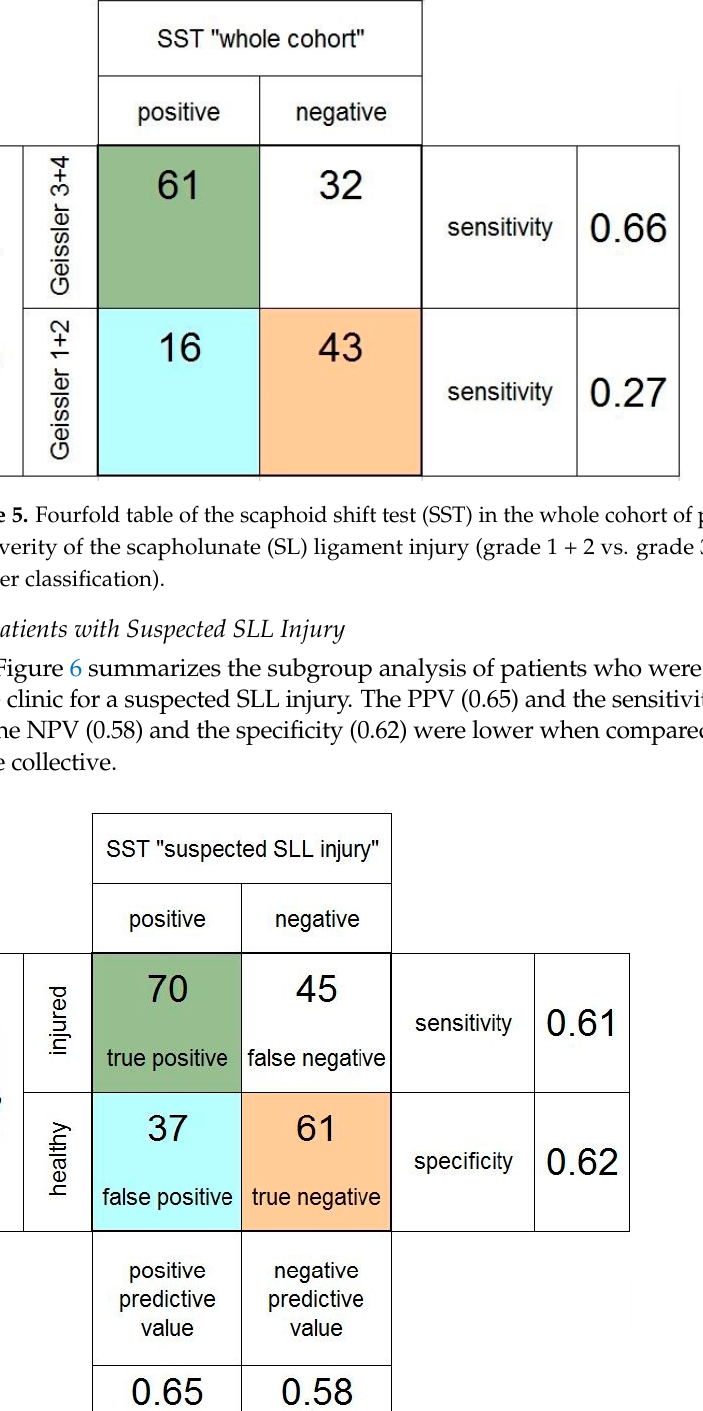
Figure 6. Fourfold table of the scaphoid shift test (SST) in the subgroup of patients referred specifically for suspected scapholunate (SL) ligament injury.